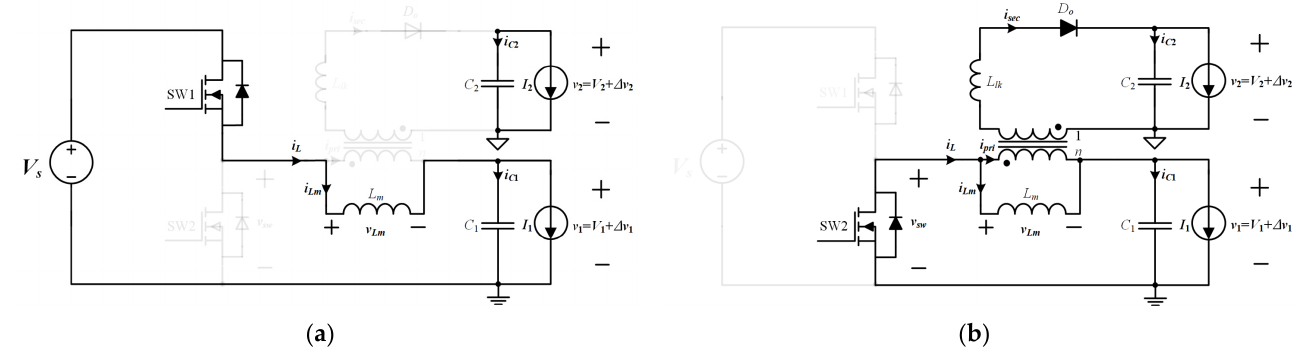
Figure 2. Operation modes of the fly-buck converter: ( a ) Buck mode; ( b ) Flyback mode.